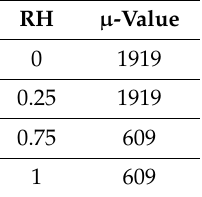
Table A24. Water vapor di ff usion resistance factor—improved model.